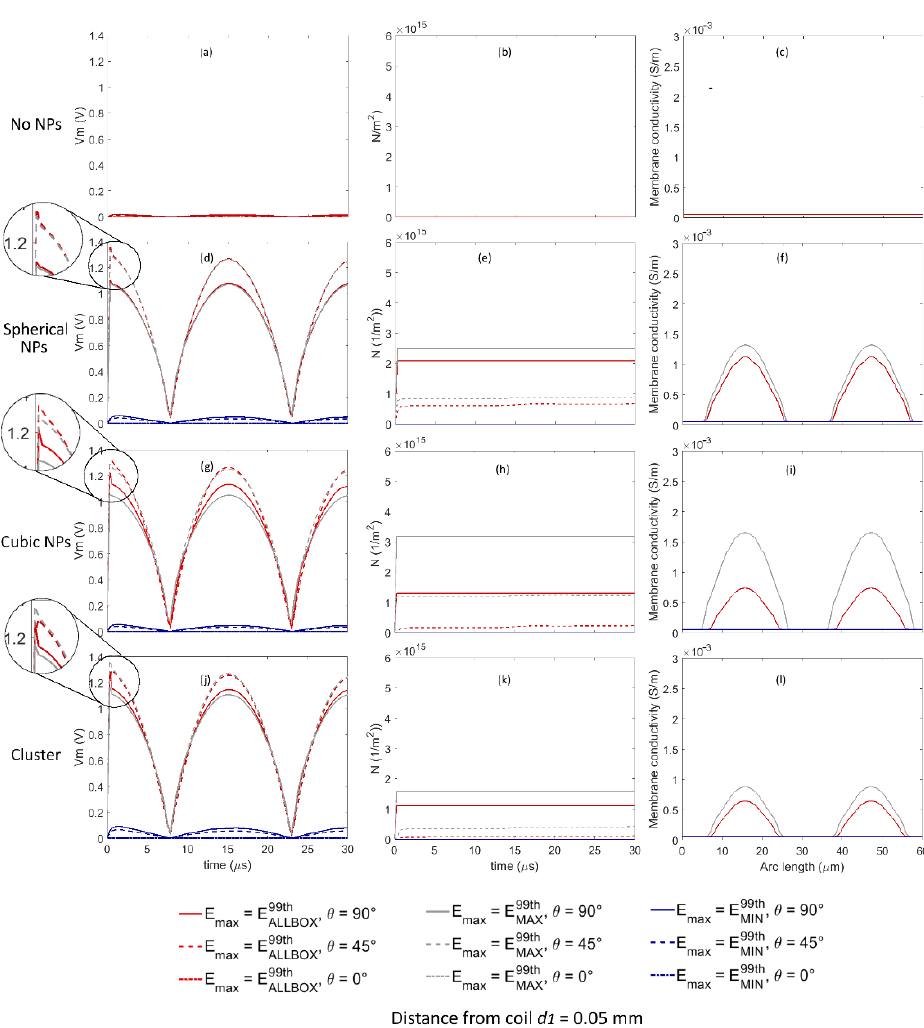
Figure 4. Time evolution of the transmembrane voltage V m (first column, ( a , d , g , j )), pore density N (second column, ( b , e , h , k )), and the variation in the conductivity along the cell membrane for t equal to 15 µ s (third column, ( c , f , i , l )) at distance d 1 from the coil, when the amplitude of the external applied electric field was equal to E 99th AllBox , E 99th MAX , and E 99th MIN , when no Au NP was considered (first row, ( a – c )), and for the spherical, cubic, and cluster Au NP configurations (second row, ( d – f ), third row, ( g – i ), and fourth row, ( j – l ), respectively).